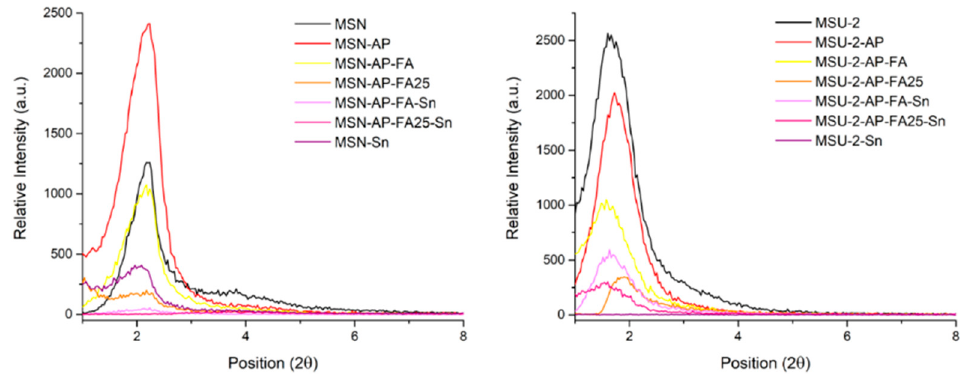
Figure 1. Low angle powder X-ray diffractograms of mesoporous silica nanoparticle (MSN)-based materials ( left ) and MSU-2-based materials ( right ).